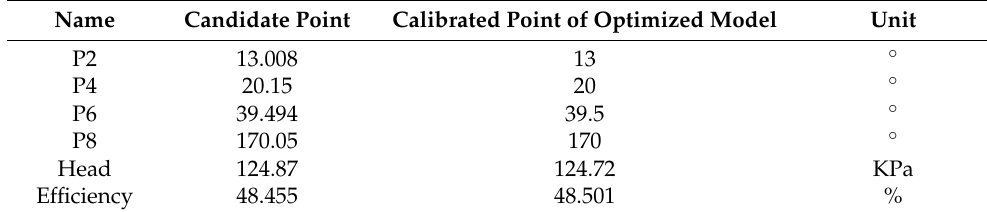
Figure 9. Pareto fronts of the optimization process. Table 5. Optimization result parameters. Table 5. Optimization result